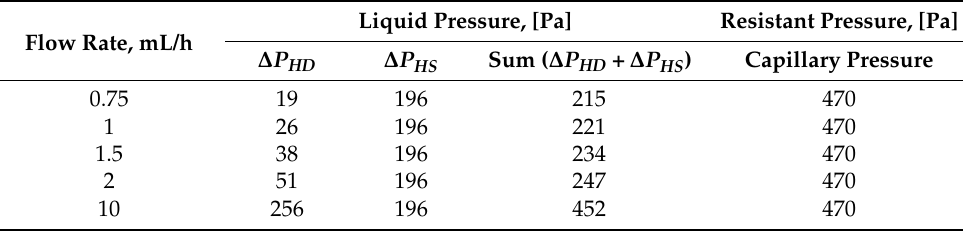
Table 1. Calculated pressures at different flow rates (assuming a standing tubing height of 2 cm). Flow Rate,